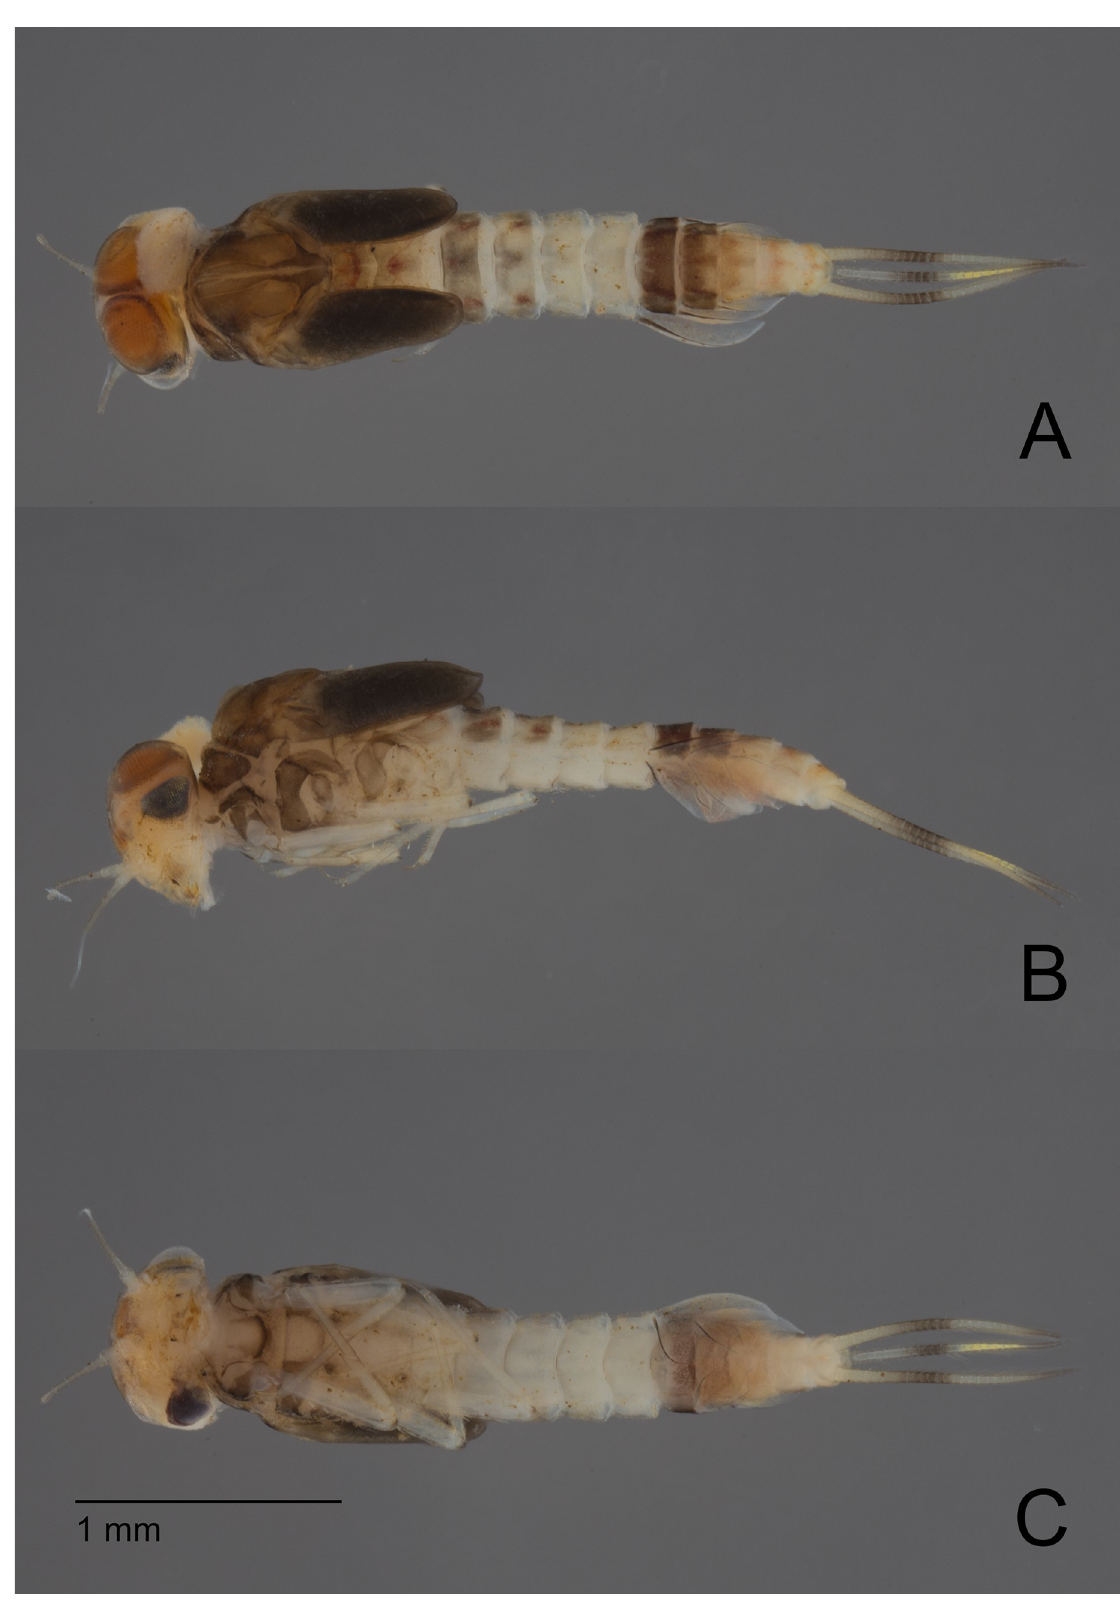
Fig 2. Cymbalcloeon sartorii gen. nov. et sp. nov. Male mature larva. (A) dorsal view, (B) lateral view, (C) ventral view. https://doi.org/10.1371/journal.pone.0240635.g002 PLOS ONE | https://doi.org/10.1371/journal.pone.0240635 October 13,